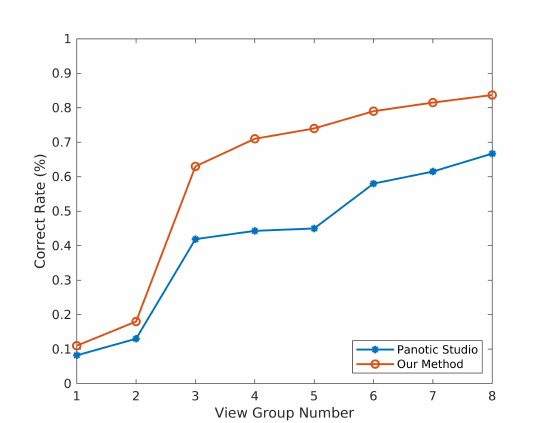
Figure 8. Positions of 12 Camera Views.